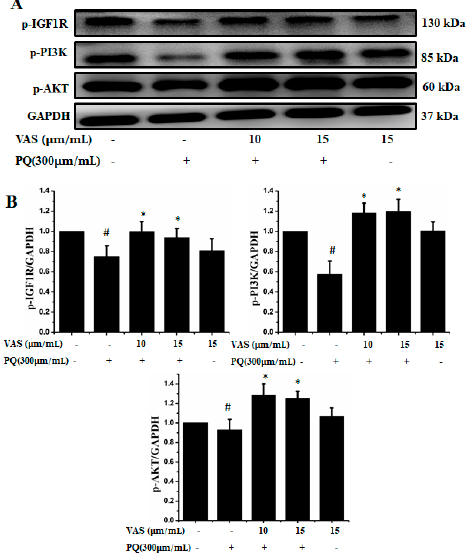
Figure 7. Effects of vasicinone on the activation of insulin-like growth factor 1 (IGF-1R)/PI3K/AKT Figure 7. E ff ects of vasicinone on the activation of insulin-like growth factor 1 (IGF-1R) / PI3K / AKT si gnaling. (A) SH-SY5Y cells were treated with vasicinone for 24 hr and then exposed to paraquat for signaling. ( A ) SH-SY5Y cells were treated with vasicinone for 24 h and then exposed to paraquat for an additional 24 h. Total cell lysates were prepared to determine the protein expression of cell survival-related proteins. GAPDH was used as an internal control protein. ( B ) IGF-1R, PI3K and AKT were determined by densitometry analysis. Three independent experiments were performed for this assay. Results are shown as the mean ± SD. # p < 0.01, compared with control cells; * p < 0.01, compared with paraquat-treated